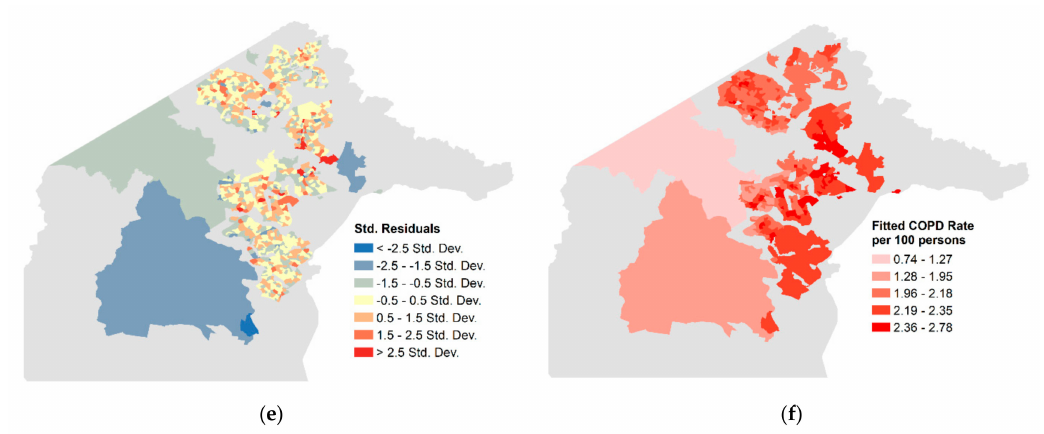
Figure 2. Maps of COPD rate and GWR results for residential areas in the ACT: ( a ) COPD rate; ( b ) GP coe ffi cients; ( c ) Under5 coe ffi cients; ( d ) IRSAD coe ffi cients; ( e ) Std. residuals; ( f ) Fitted